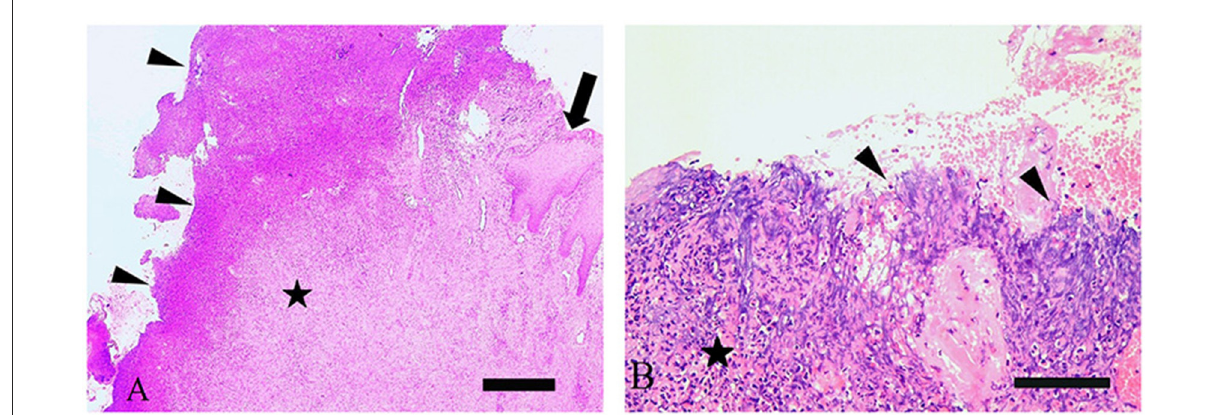
FIGURE2 (A) Histological investigation of bovine digital dermatitis (BDD)-associated axial horn fissure revealed severe fibrosis (star) of dermis, focal areas with nests of epidermis (arrow) and large areas with ulceration covered by cellular debris (arrowheads). H&E, bar 500 µ m. (B) BDD-associated sole ulcer covered by cellular debris (arrowheads), superficial bleeding and severe fibrosis (stars) of dermis. H&E, bar 200 µ